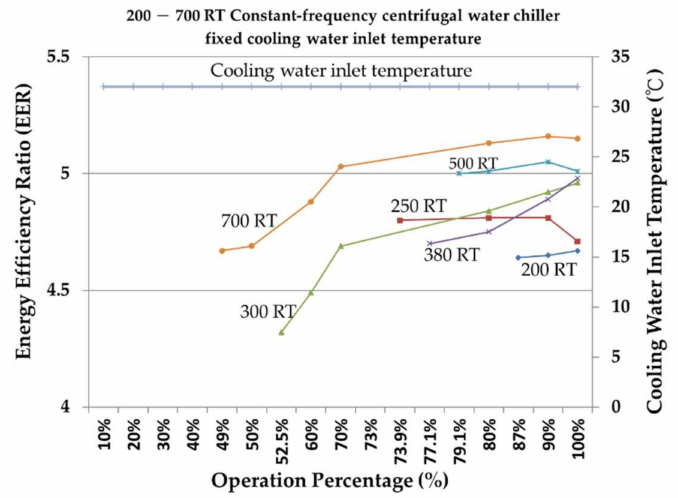
Figure 8. Fixed-cooling water inlet temperature EER of the 200–700 RT constant-frequency centrifugal water